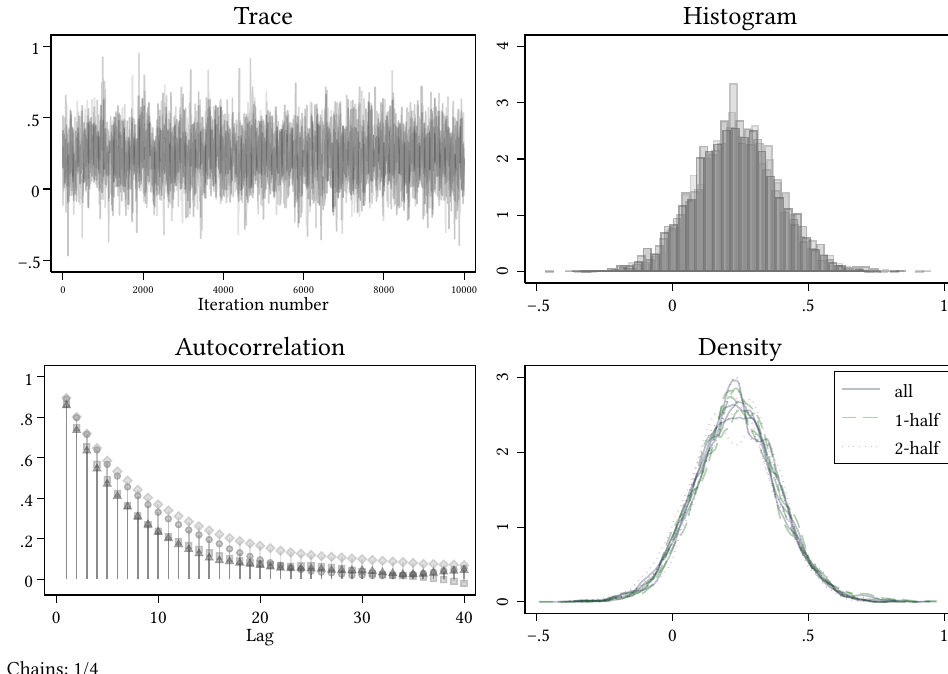
Figure A3. How awareness of the price effect influences the response to the market price. The High Info group.